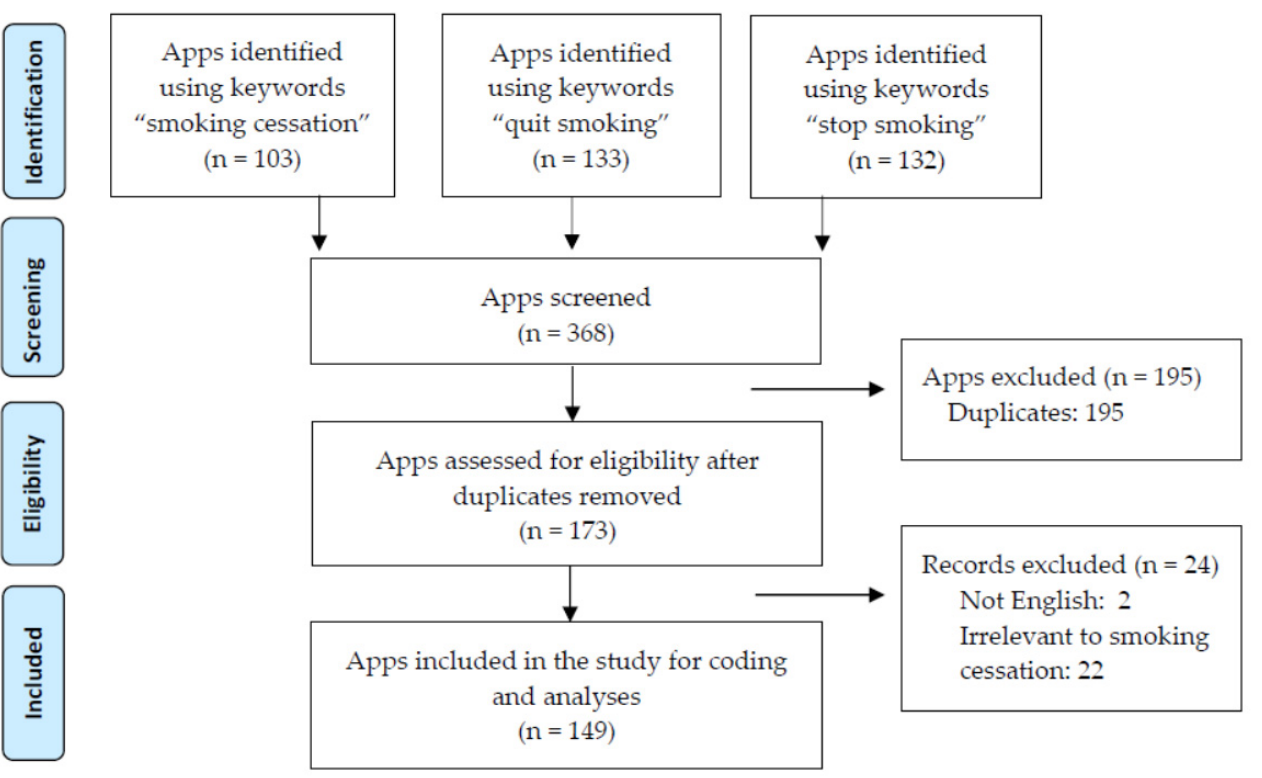
Figure 1. Summary of the selection process used in the study.